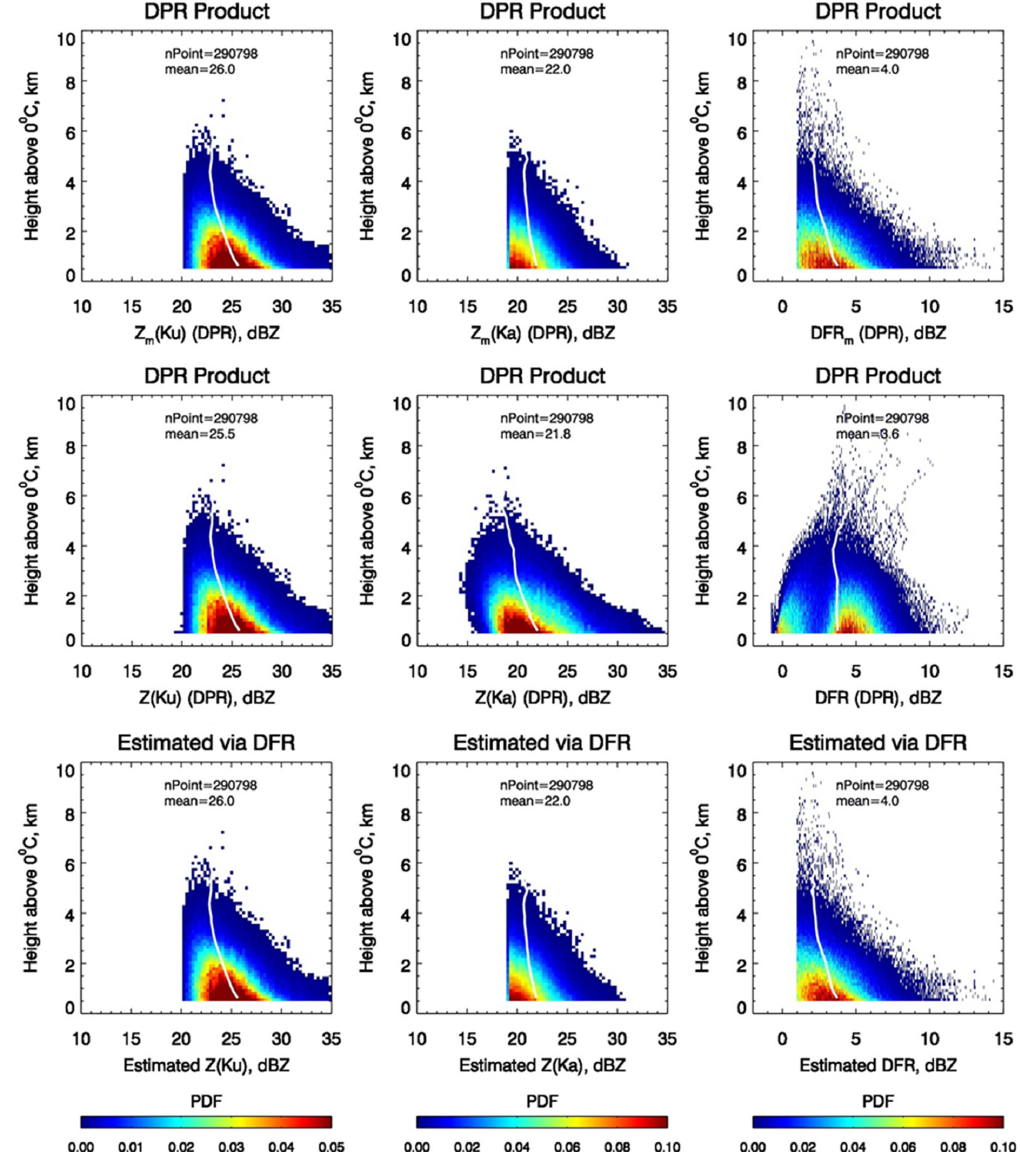
Figure 5. PDFs of the measured ( top row) and attenuation-corrected ( middle row) reflectivities obtained from the DPR standard product as well as the attenuation-corrected reflectivities derived from the DFR-based approach as a function of the height above 0 ◦ C. The data are taken from 16 DPR orbits of data on 1 January 2020, and only those data classified as stratiform are included. The white lines represent the means of the data at each height while total number of data points and the means are denoted by ‘nPoint’ and ‘mean’,